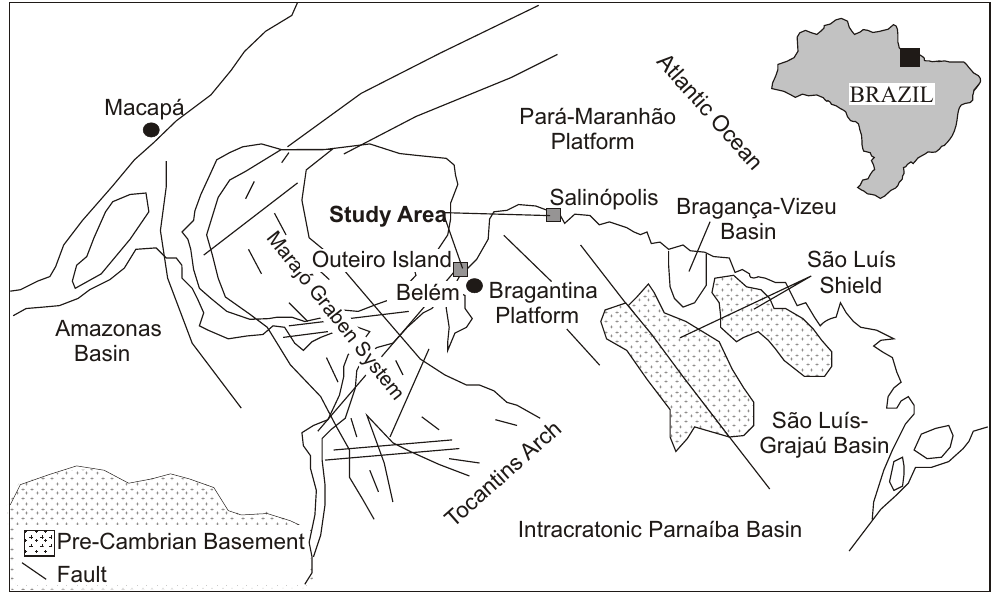
Fig. 1 – Location map of the study area in northeastern Pará State, Brazil. The two boxes indicate the areas of the Bragantina Zone where shallow Neogene deposits have been imaged using